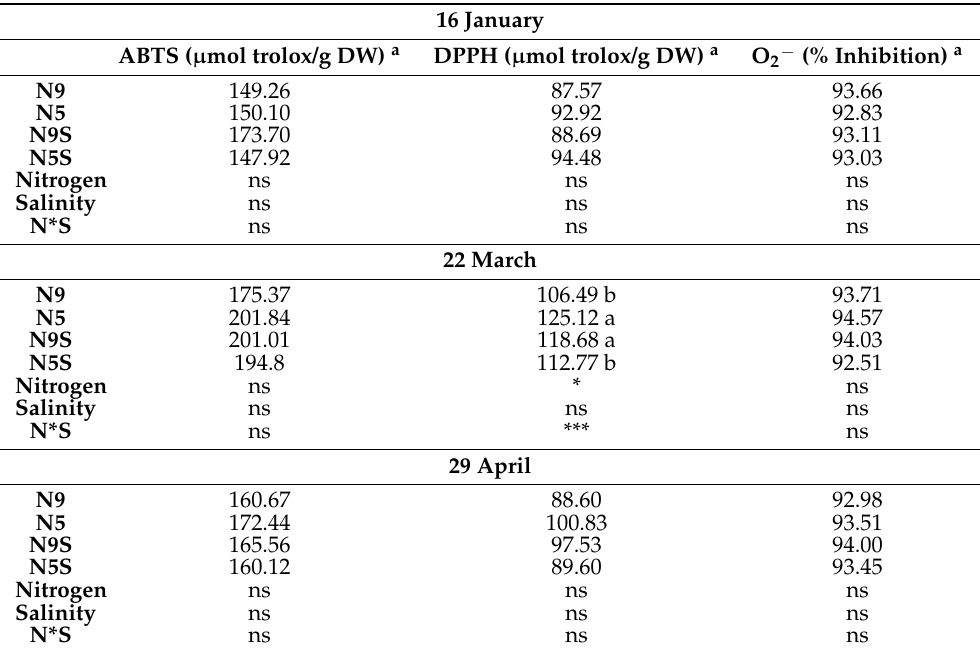
Table 5. Effect of variables on the antioxidant capacity measured in strawberry extracts.